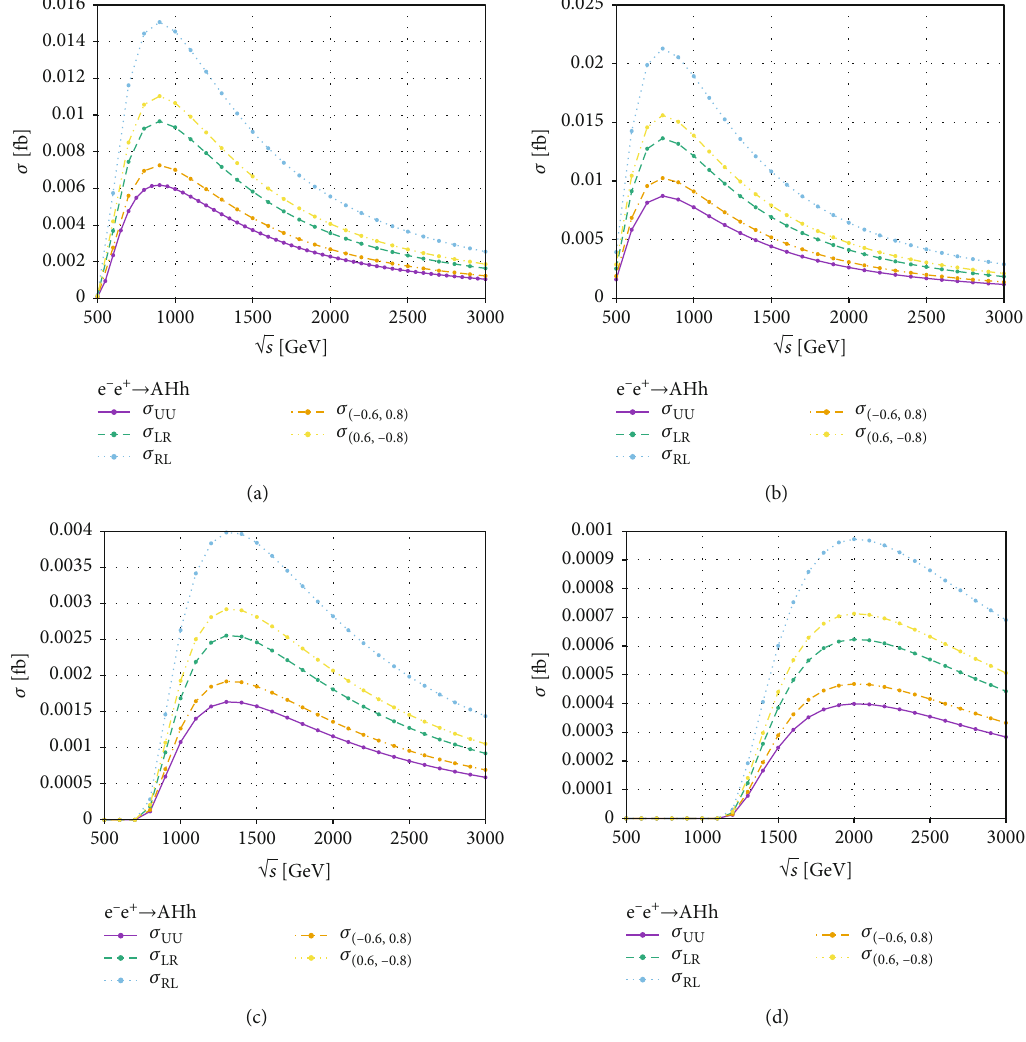
ffiffi p ( GeV ) is ploted in all these plots. Higgs mass values m ϕ = 150 GeV , s